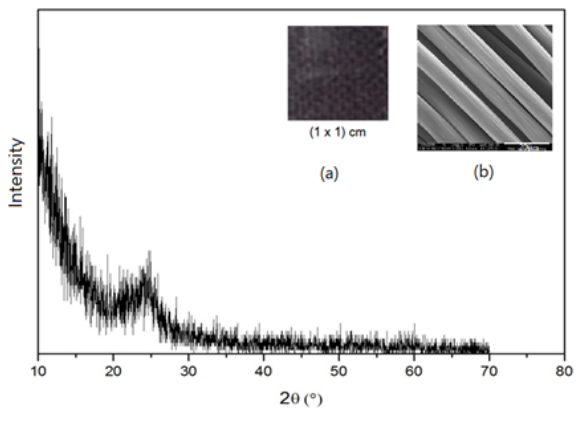
Figure 1: The XRD pattern of C fiber along with its optical image (a), and its SEM image (b).